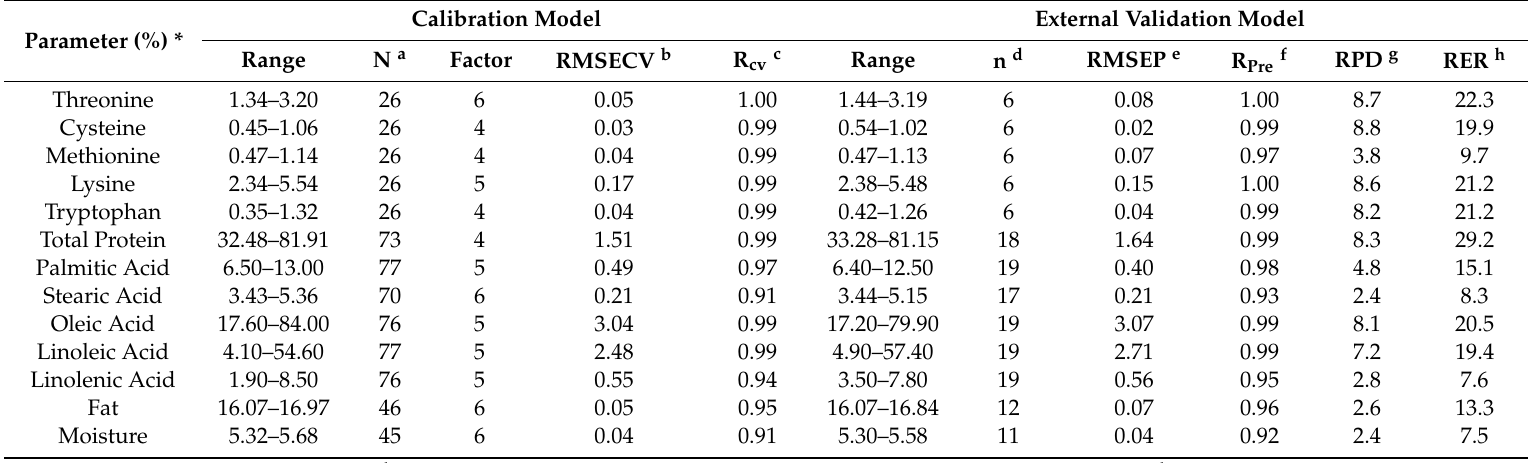
Table 3. Statistical performance of the prediction models developed using a handheld NIR sensor for estimating various constituents of soy